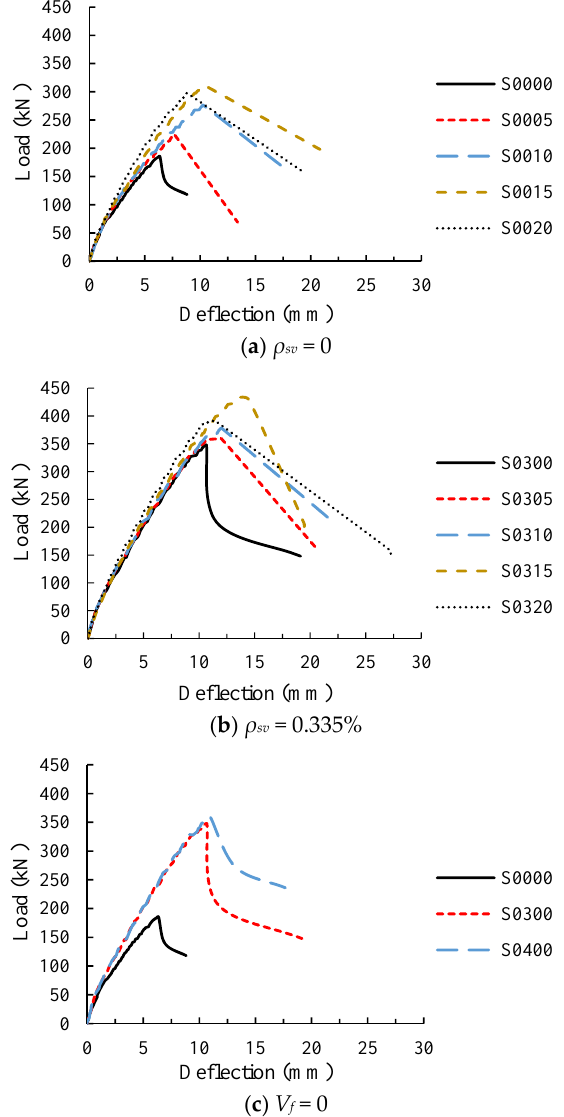
Figure 5. Load-deflection curves of specimens. ( a ) The test beams without stirrups; ( b ) The test beams with stirrup ratio 0.335%; ( c ) The test beams without steel fiber.